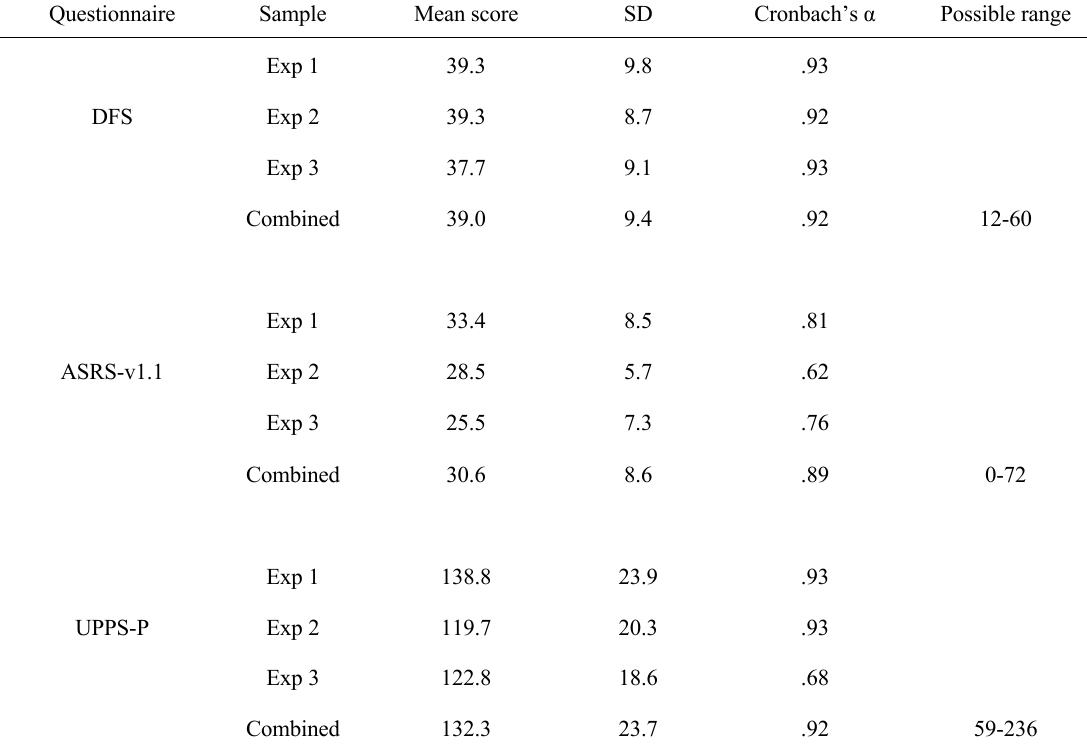
Table 1. Overview of the Daydreaming Frequency Scale (DFS), the Adult ADHD Self-Report Scale (ASRS-v1.1), and the UPPS-P Impulsive Behaviour Scale (UPPS-P). Shown are the mean scores and standard deviations (SD) over all the participants, as well as the internal consistency (Cronbach’s α) for each questionnaire, for each sample separately as well as for the combined data. Also shown are the minimum and maximum possible scores of each